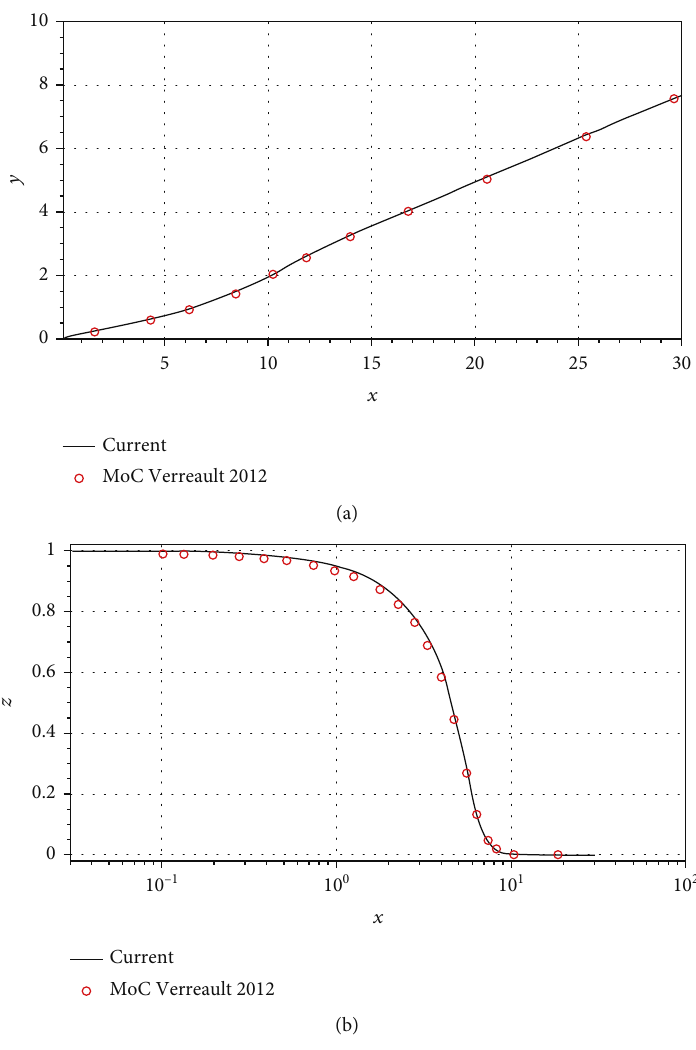
= 20 ). (a) Shock trajectory. (b) Mass fraction of reactant along the wedge Figure 2: Low activation energy case ( E A